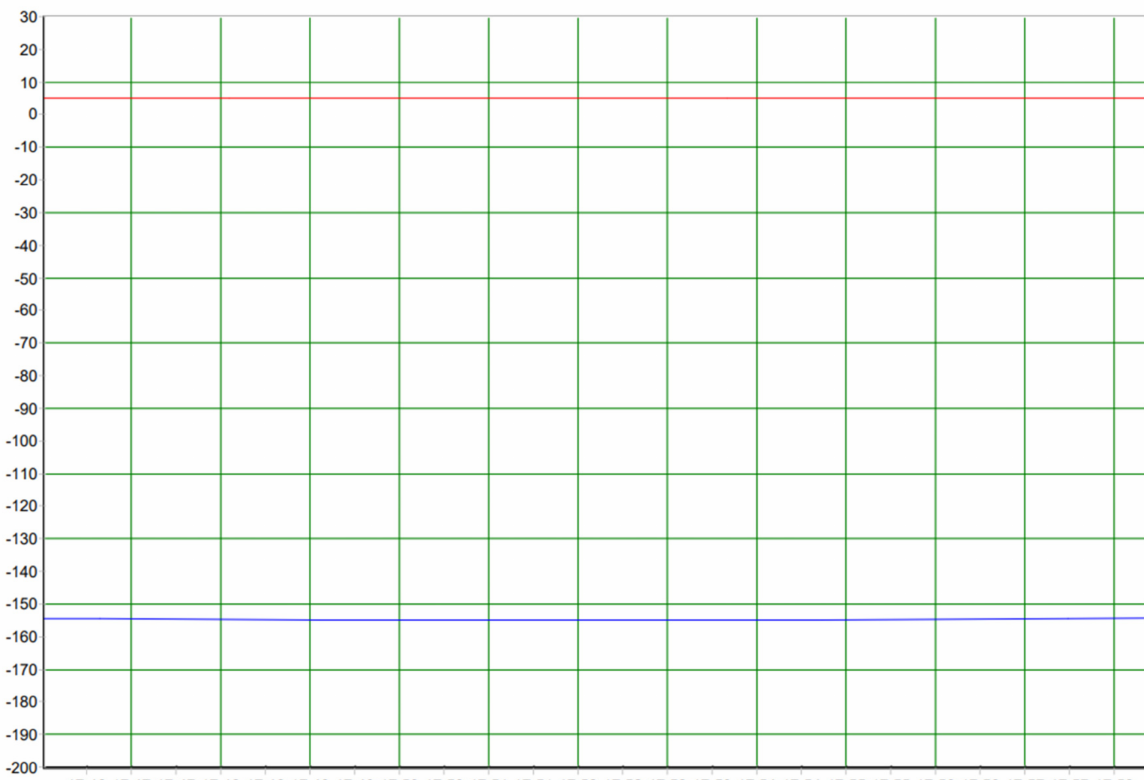
Figure 14. Variation curve of temperature inside the kettle wall and pressure inside the